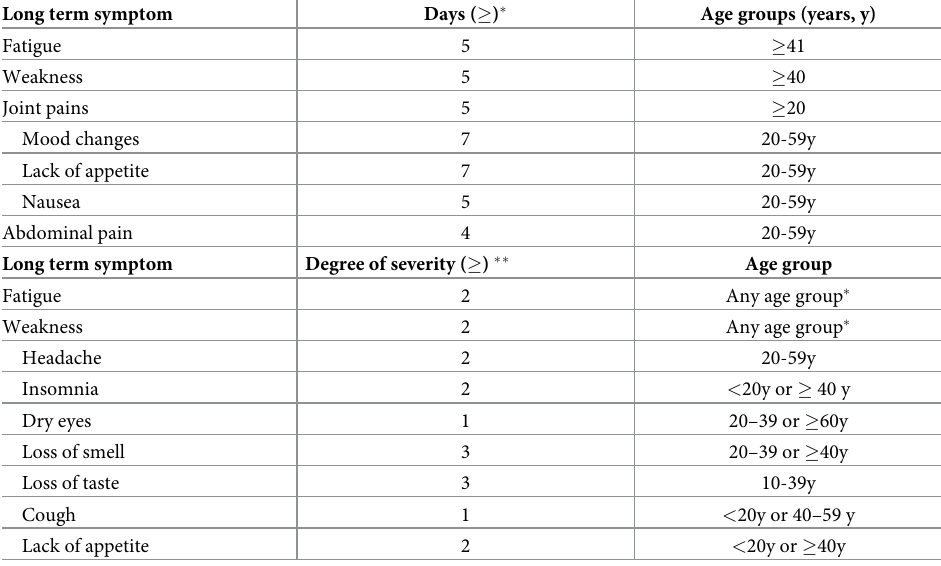
Table 4. (Level-1 A): Scoring Post-recovery COVID-19 long term symptoms persistence (High concerns groups) . Scoring method: One point given for each item per symptom (one point for days and one point for age group). Inter- pretation: Score two for any symptom: follow up is recommended for the patient for each symptom got score 2. (Level 1 B): Scoring Post-recovery COVID-19 long term symptoms degree of severity (High concerns groups) .